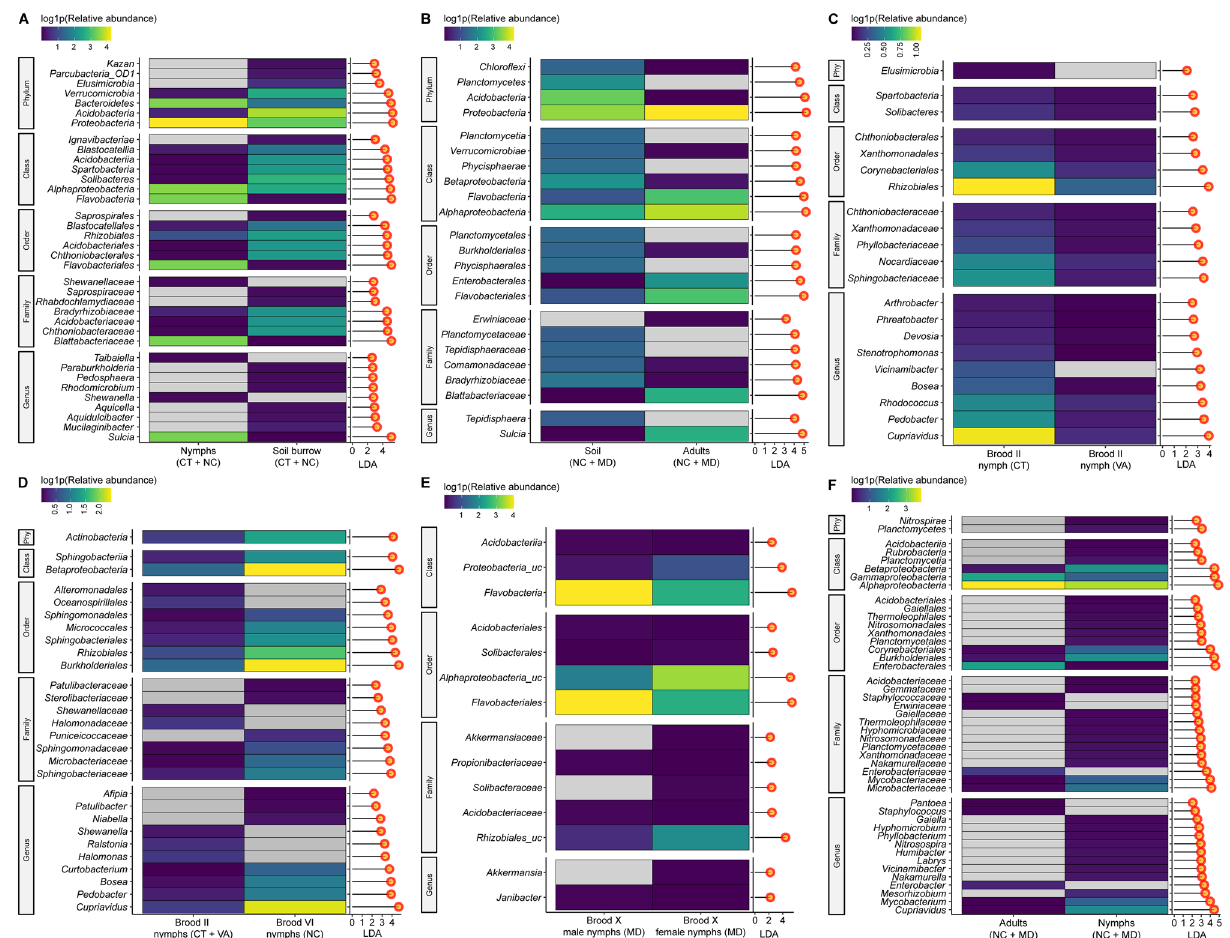
Figure 6. Taxonomic biomarkers calculated using LEfSe 32 . Heatmap (left) provides log10 10 (relative abundance) of taxonomic biomarkers at the genus level. Bar plot (right) shows linear discriminant analysis (LDA) effect size used to support high-dimensional class comparisons of ( A ) Brood II nymphs (CT) and Brood VI nymphs (NC) versus soil inhabited by nymphs (CT and NC), ( B ) Adults (Brood X, MD, and Brood VI, NC) versus soil (MD and NC), ( C ) Brood II (CT) versus Brood II (VA), ( D ) Brood II nymphs (CT and VA) versus Brood VI